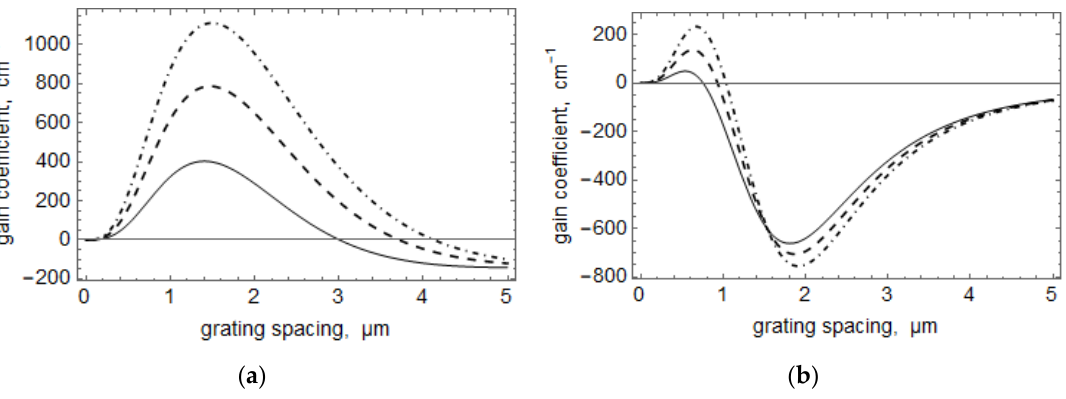
r on the gain coefficient. ( a ) p L = , ( b ) / 4 p L = 1 r = − 3. 2